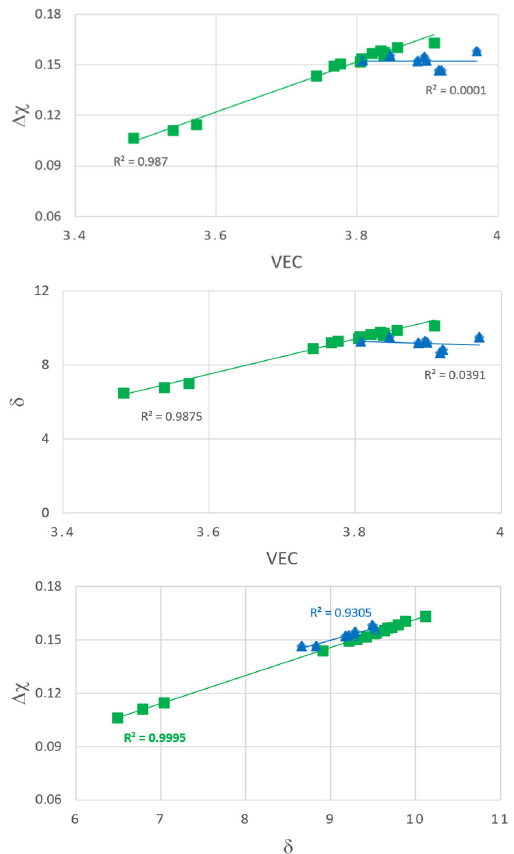
Figure 17. Plots of the parameters valence band (VEC), δ and ∆ χ for the microstructures of the cast and heat treated alloys Nb 1.7 Si 2.4 Ti 2.4 Al 3 Hf 0.5 (blue triangle) and Nb 1.3 Si 2.4 Ti 2.4 Al 3.5 Hf 0.4 (green squares).